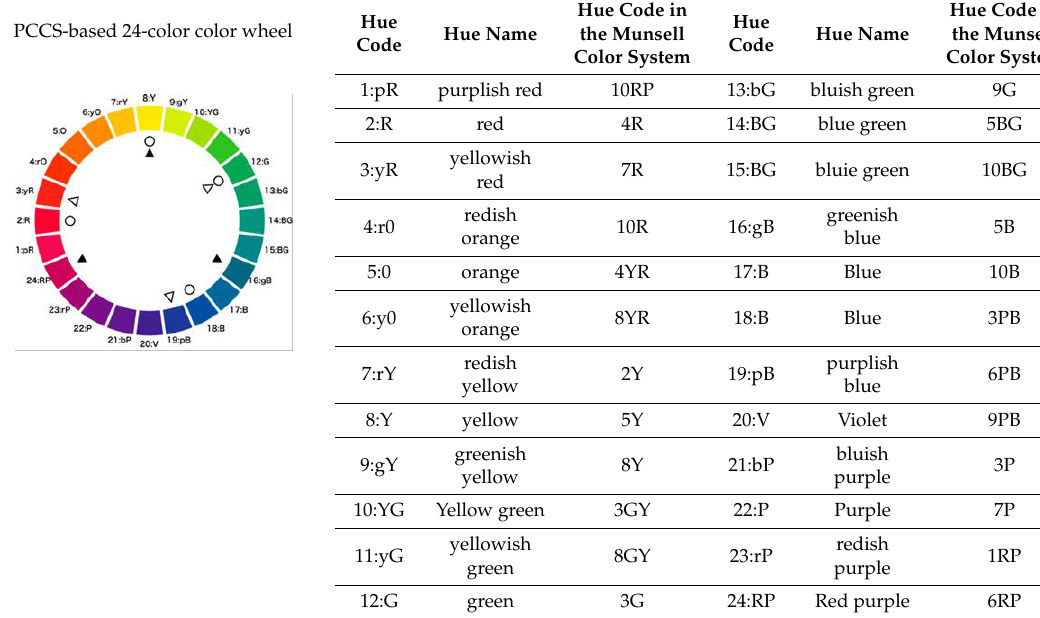
Table 2. Structure of 24-color Practical Color Coordinate System (PCCS) color wheel. PCCS-based 24-color color wheel